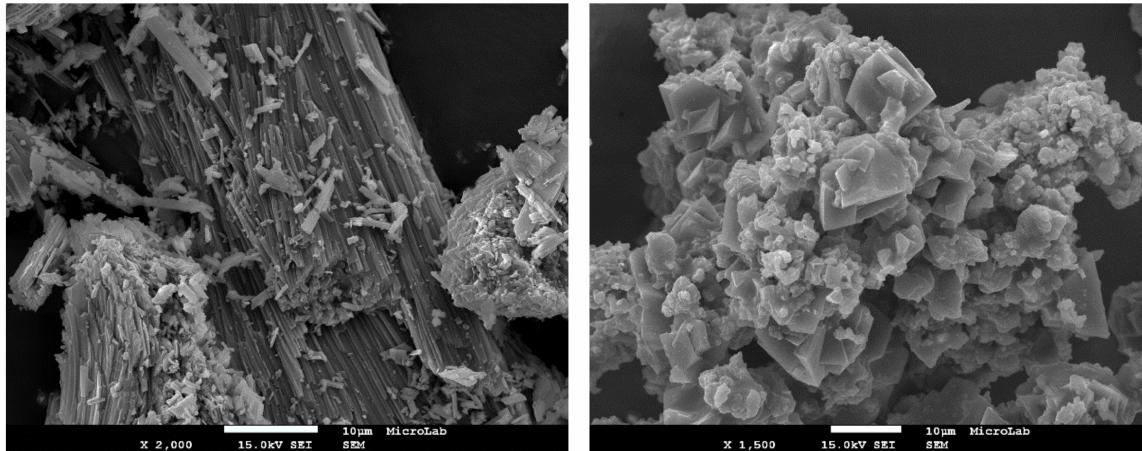
Figure 3. SEM micrographs of raw and calcined scallop shells.